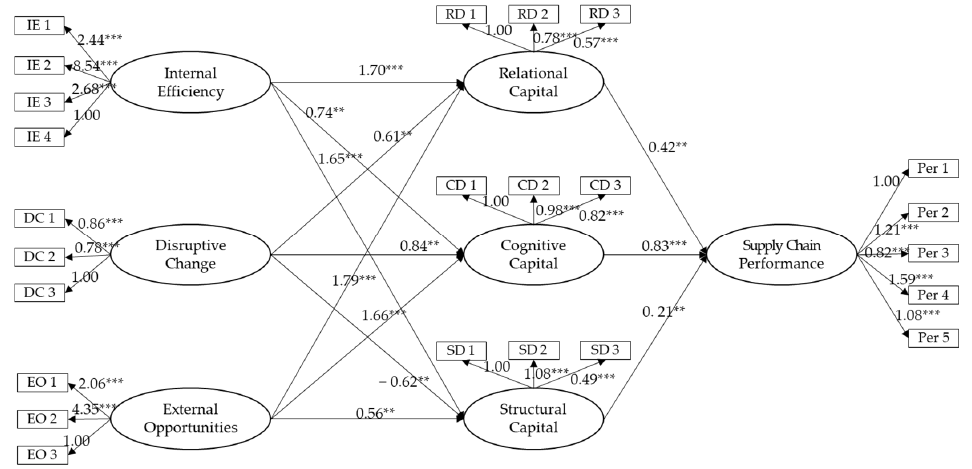
Figure 2. The research model results; ** p < 0.05, *** p < 0.01 . According to the results of the relationship between social capital and supply chain performance (H2), the effect of relational capital on supply chain performance was β = 0.42 ( p = 0.039). Next, the effect of cognitive capital on supply chain performance was β = 0.83 ( p = 0.008). The effect of structural capital on supply chain performance was β = 0.21 ( p = 0.046). H2 was therefore supported.